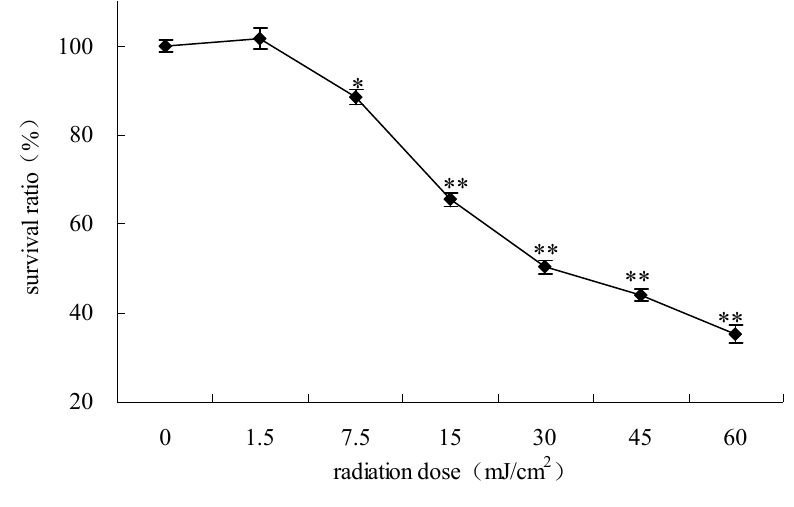
Figure 1. The survival ratios of HepG2 cells irradiated at different UV dose. Each value represents the mean of three experiments. * p < 0.05, ** p < 0.01, compared with control group.